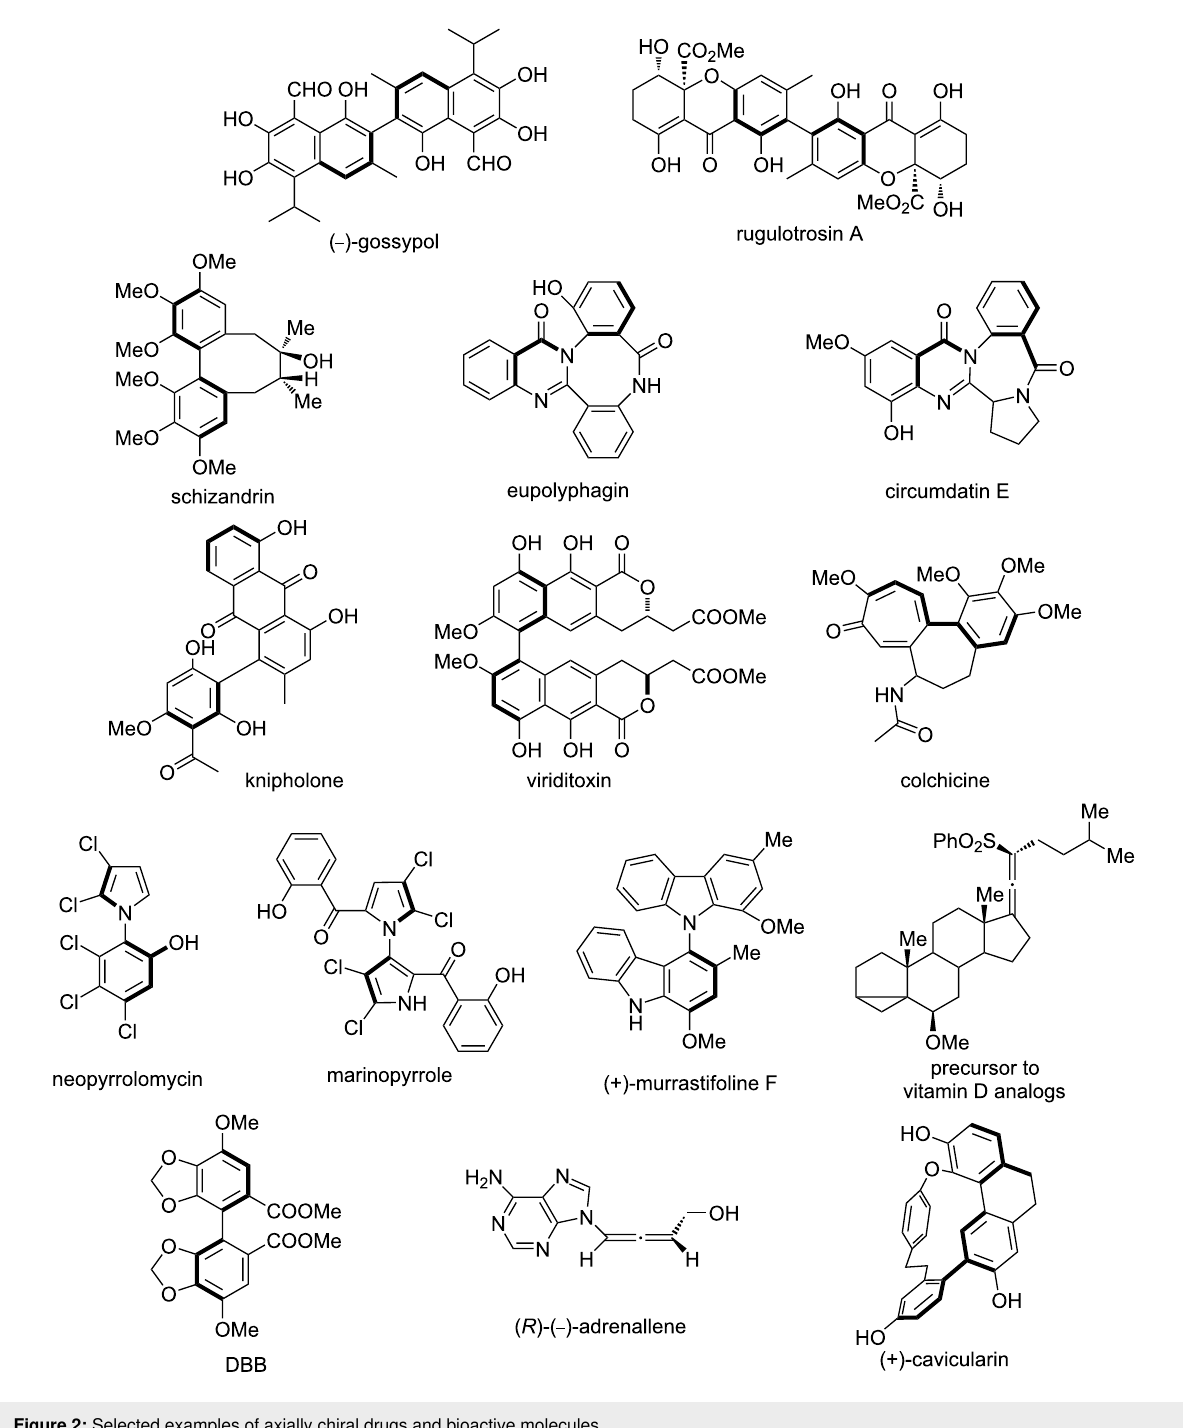
Figure 2: Selected examples of axially chiral drugs and bioactive molecules.